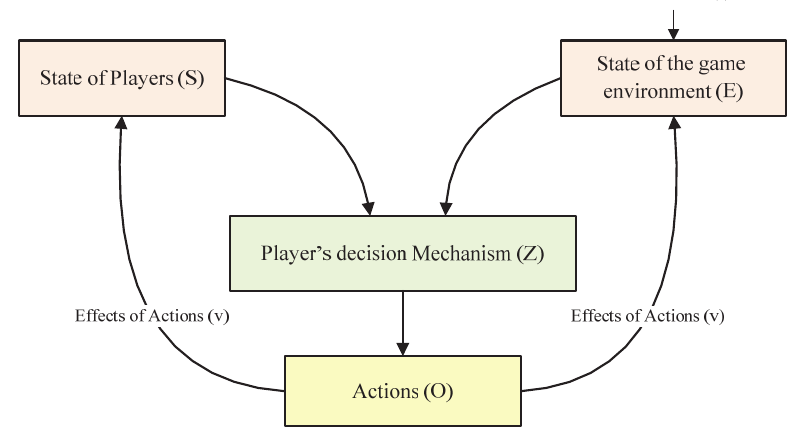
Fig. 1. The structure of system dynamics